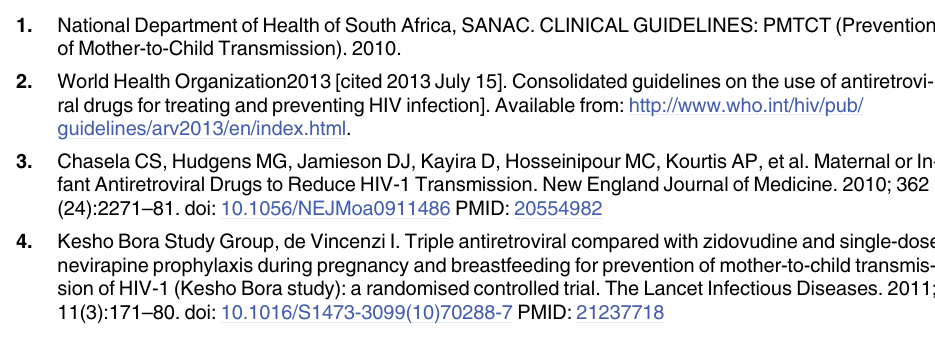
S1 Table. Survey Sample Size Calculations. S2 Table. Distribution of individual variables that contributed to the overall socio-econom- ic status (SES) score levels of average, lower than average and lowest SES. S3 Table. Weighted risk factors of the maternal HIV seroconversion during pregnancy, South Africa, 2011 – 2012 (Full